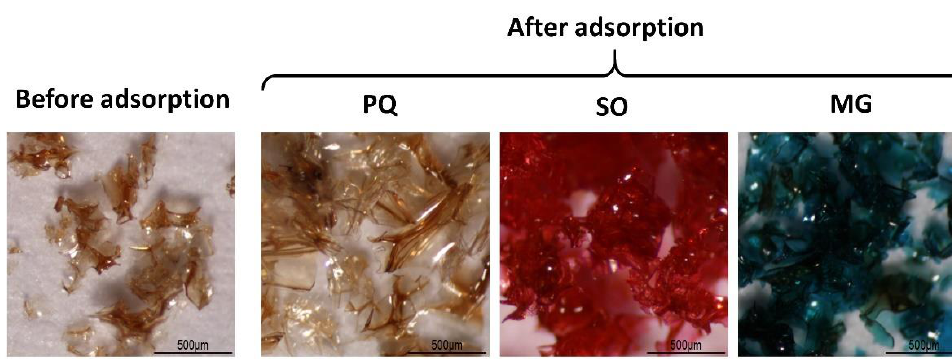
Figure 9. Physical appearance of nanosponges before and after contaminant adsorption.